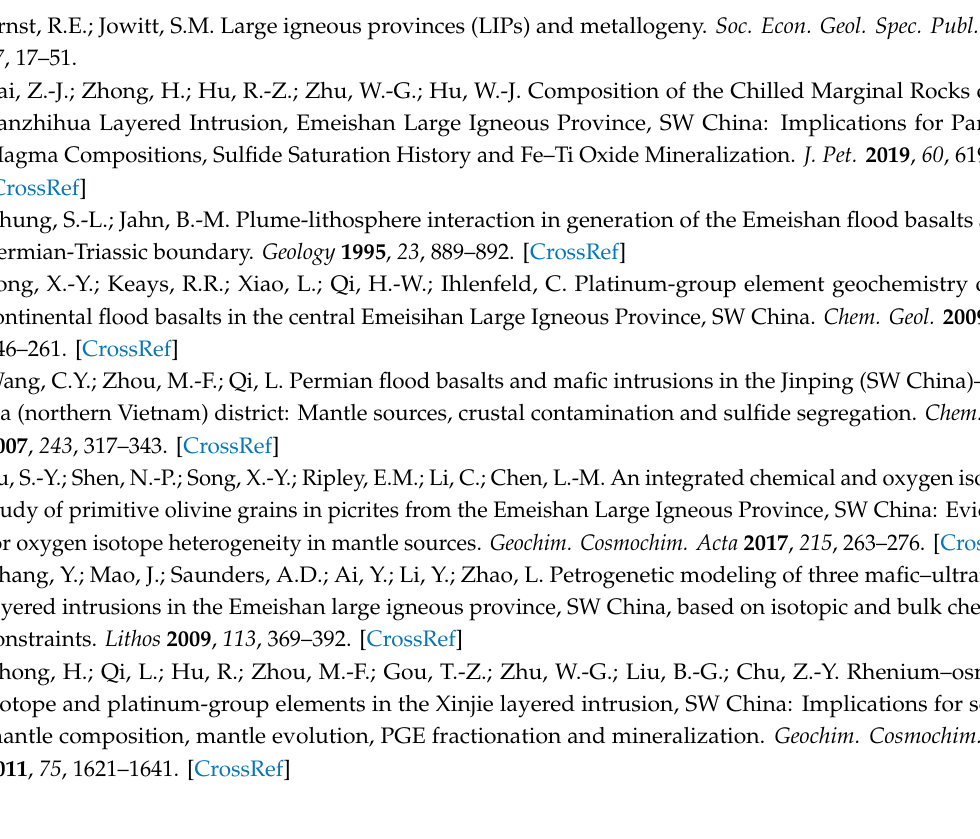
Figure S1: Major and trace elements composition of the whole rock. (a) TiO 2 versus MgO; (b) SiO 2 versus MgO; (c) CaO versus MgO; (d) Al 2 O 3 versus MgO; (e) Ni versus MgO; (f) Cr versus MgO; (g) Sr versus MgO; (h) V versus MgO. Figure S2: Major element composition of the Cpx phenocryst from high-Mg and low-Mg basalts. (a) TiO 2 versus SiO 2 . (b) Al 2 O 3 versus SiO 2 . (c) Cr 2 O 3 versus SiO 2 . (d) iv Al versus Al 2 O 3 . (e) Si + Mg (pfu) versus Al (pfu). (f) Mg (pfu) versus Al (pfu), Figure S3: Elemental profles (C to D) for the zoned Cpx phenocryst of the high-Mg basalts (sample YY13-123). Profle analysis shows oscillatory zonings in the elements of Si, Mg, Cr, Ti and Al. The MgO and Cr 2 O 3 show strong negative correction with the Al 2 O 3 , TiO 2 and FeO. The {010} shows Al 2 O 3 , TiO 2 FeO enrichment compared with the {100}. (a–h) Major elements variations along the line (from C to D), Figure S4: (a) Fe-Mg partitioning between Cpx phenocrysts and matrix. (b) Fe-Mg partitioning between Cpx phenocrysts and the matrix which extra olivine has been eliminated. (c–f) Measured and calculated values for Cpx phenocrysts components (mole fraction) from the picrite and basalt. (DiHd-diopside + hedenbergite, EnFs-enstatite + ferrosilite, CaTs-Ca-Tschermak, and Jd-jadeite. The equilibrium envelopes are marked by the standard error of estimate (SEE), which are for diopside-hedenbergite ± 0.06 SEE; enstatite-ferrosillite ± 0.05 1SEE from Mollo et al. (2013) [45]; Ca-Tshermack ± 0.08 2SEE and Jadeite ± 0.04 2SEE from Putirka (1999) [84])., Table